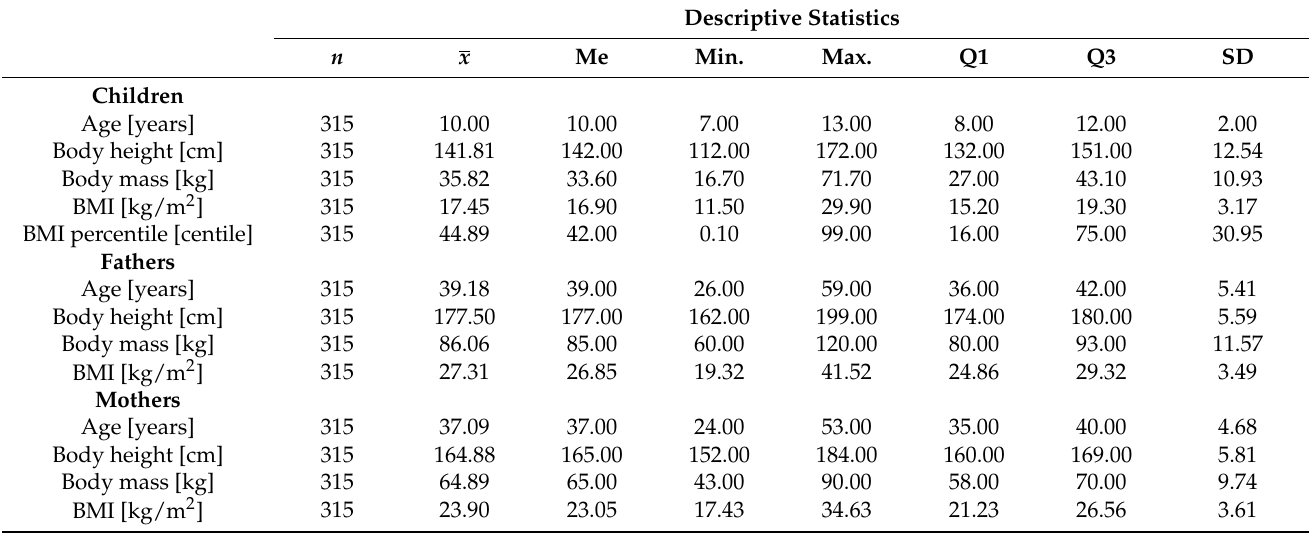
Table 1. Characteristics of the study group—descriptive